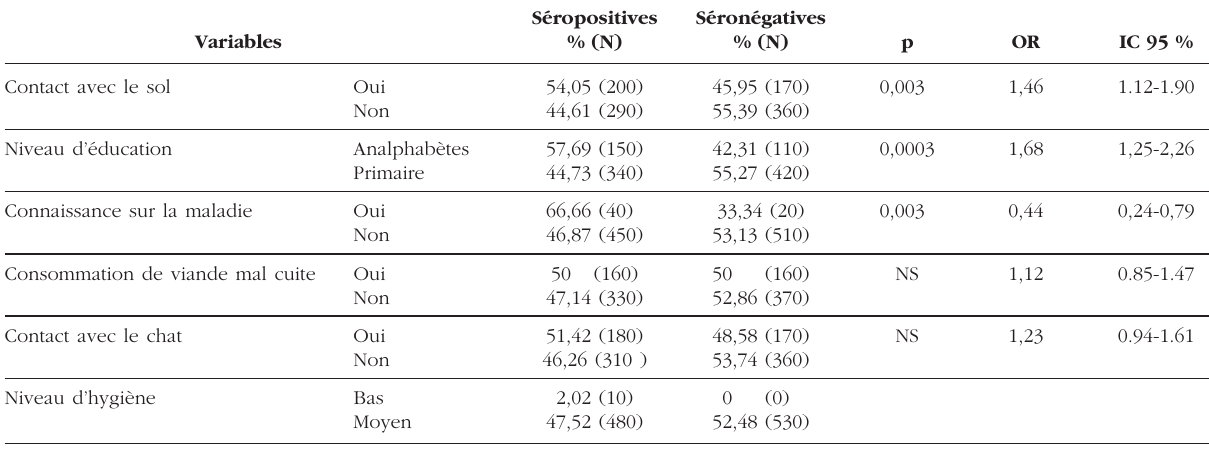
Tableau I. – Analyse bivariée des facteurs influençant la séropositivité de la toxoplasmose chez les femmes.